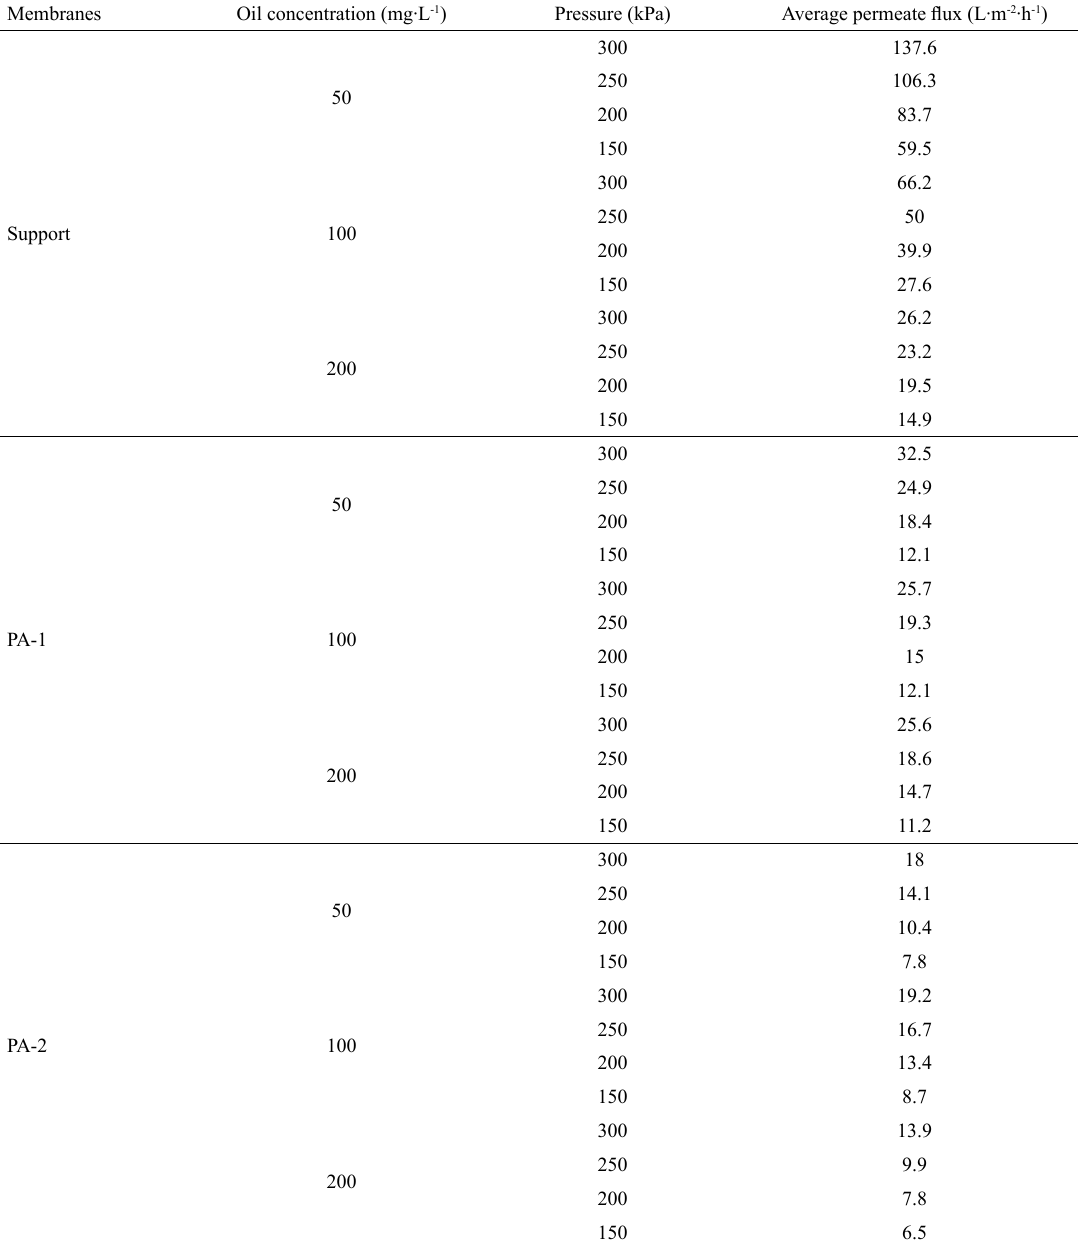
Table 1. Result of average values of the permeate flux to the ceramic support and to the PA-1 and PA-2 membranes.